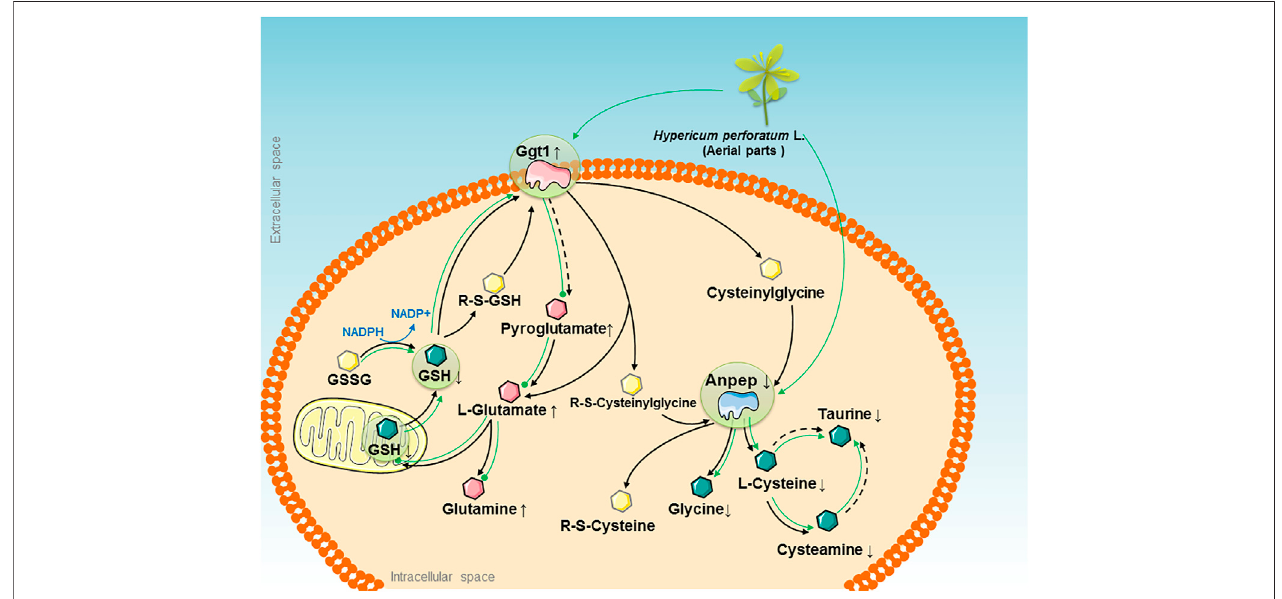
FIGURE5| Thetherapeutic “ bigpicture ” of “ HPL-disease-gene-metabolite ” networksmodulatedbytheHPLtreatmentinratswithOVX-inducedglutathioneredox stress. OVX-induced glutathione redox stress triggered abnormalities in pathways that are presented as black solid arrows that link the main glutathione metabolism pathway, and black dotted arrows indicate indirect catalytic reactions. Signi fi cant upregulation of Ggt1 and Anpep is represented by pink and blue irregular shapes, respectively. The increased and decreased levels of quanti fi ed metabolites are represented by pink and green hexagons, respectively. Other metabolites are represented by yellow hexagons. The effects of HPL therapy on reversing the increased levels of metabolites are represented by dotted green lines, while the effects on restoring the decreased levels of metabolites are represented by solid green